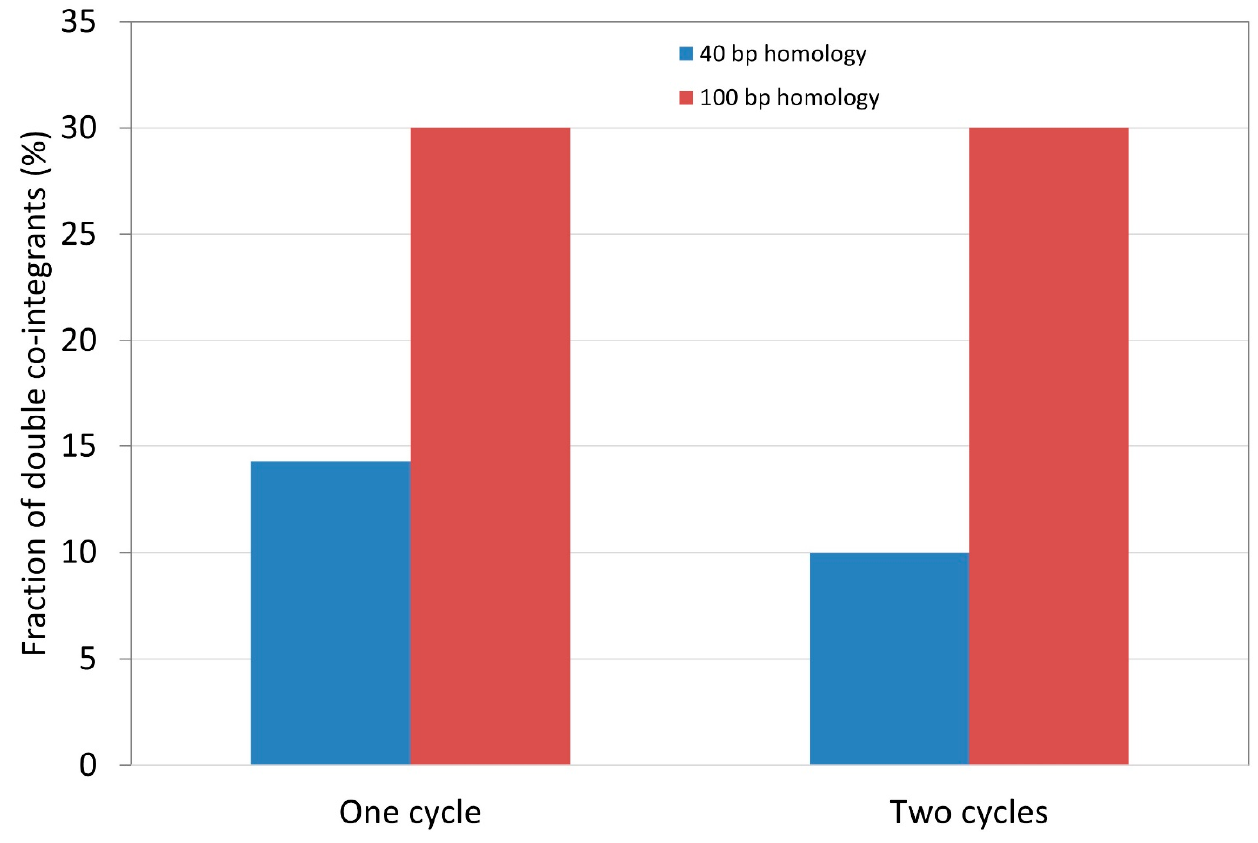
Figure 4. Efficiency of engineering double co-integrants. The IS 1 elements of E. coli MDS39R2 were targeted by recombineering followed by consecutive pCas9IS1-mediated counterselection. The fraction of colonies harboring an SpR cassette within both chromosomal IS 1 elements are shown after one or two cycles of recombineering and one round of counterselection. Blue bars depict the use of short (40 bp) and red bars depict the use of long (100 bp) homologies. An exemplary experimental outcome is displayed from a set of two similar experiments.